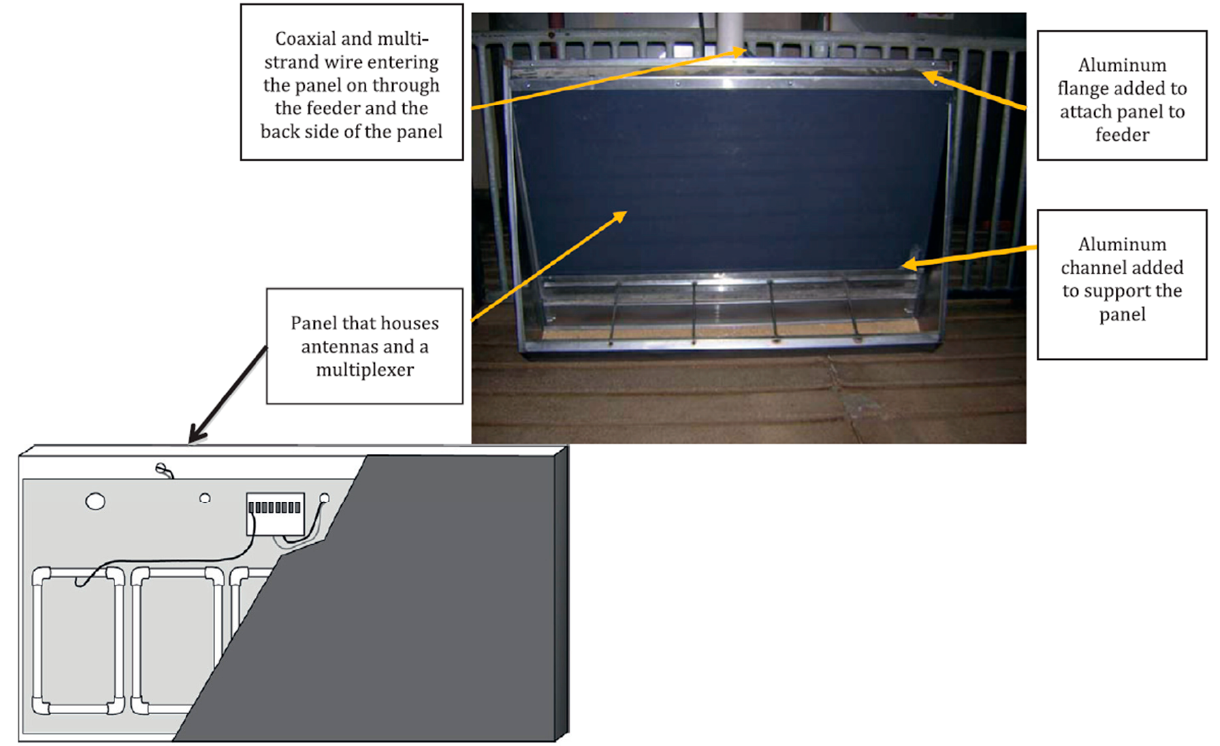
Figure 5. Schema of the panel and a photo of the panel after installation (Source: [25]). Labroue et al. [11] used a system referred to as “ACEMA 48” (Figure 4). This system consists of a trough, which allowed them to weigh the feed and a gate to avoid the entrance of more than one pig into the trough at the same time. Feed is weighed before and